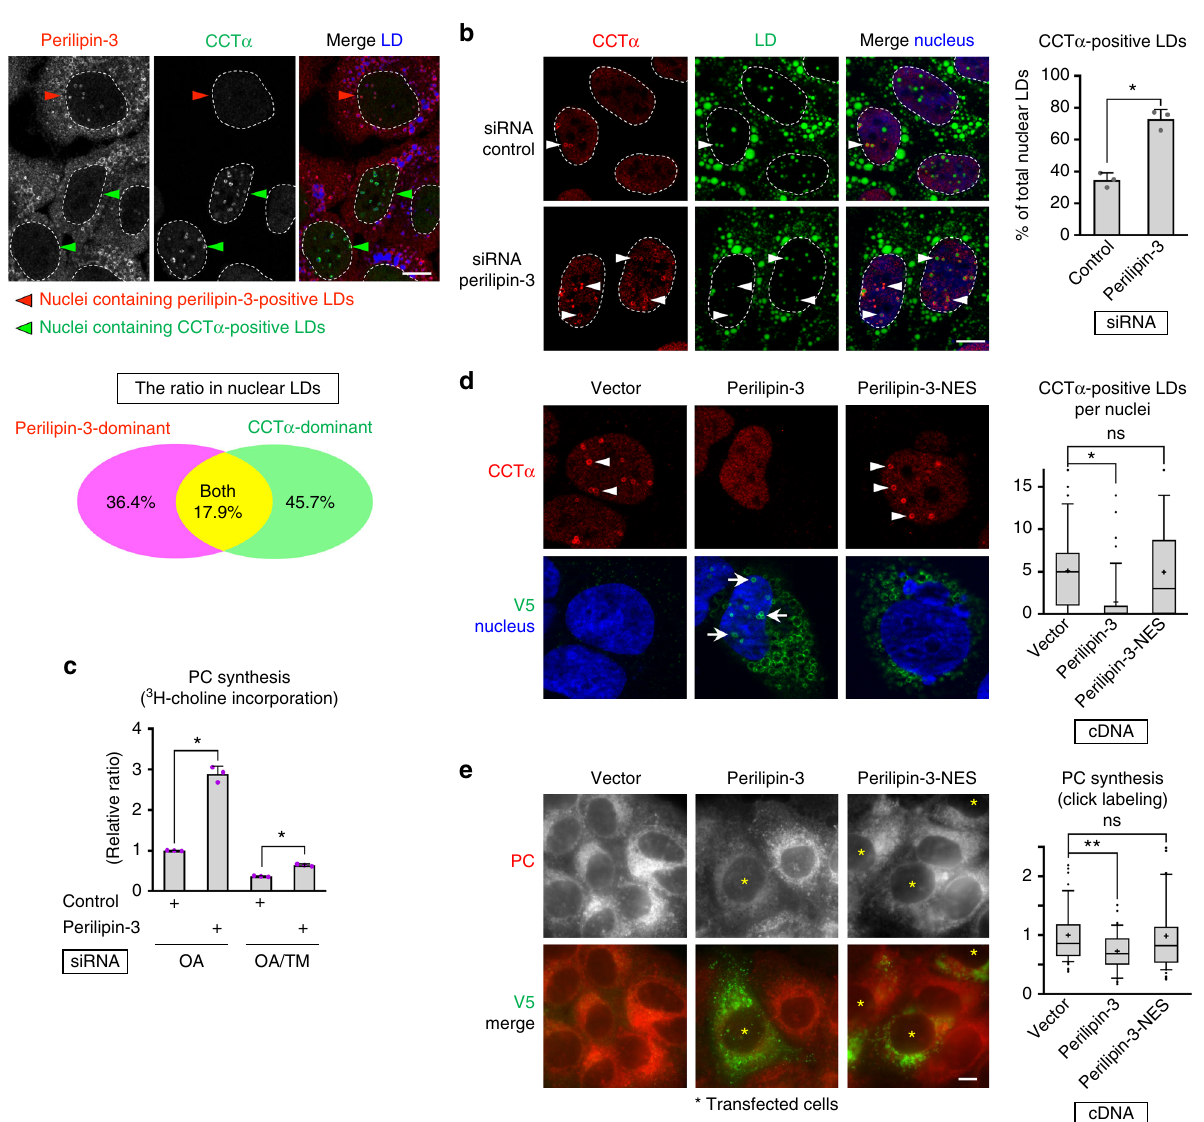
Fig. 6 CCT α recruited to nucleoplasmic LDs activates PC synthesis. a Either perilipin-3 (red) or CCT α (green) is predominant in a majority of nuclear LDs (blue). Huh7 treated with OA for 24 h. The LDs (total number, 396) were classi fi ed into perilipin-3-dominant, CCT α -dominant, and the other (see Supplementary Fig. 6c); the Venn diagram shows the proportion of the three groups. b Knockdown of perilipin-3 increased nuclear LDs harboring CCT α (arrowheads). Huh7 transfected with either control siRNA or perilipin-3 siRNA #1 was treated with OA for 24 h. CCT α (red), LDs (green), and nuclei (blue). Mean ± SD of three independent experiments. * p < 0.01, Student ’ s t test. c Knockdown of perilipin-3 increased PC synthesis. 3 H-choline incorporation to Huh7 treated as in Fig. 6b was measured. Mean ± SD of triplicate samples. * p < 0.01, Student ’ s t test. d Perilipin-3-V5, but not perilipin-3- NES-V5, decreased nuclear LDs harboring CCT α (arrowheads). Huh7 transfected with respective cDNA was treated with OA for 24 h. CCT α (red), V5 (green), nuclei (blue). Box plot of data from three independent experiments. The average is shown by + . The number of cells counted = 226